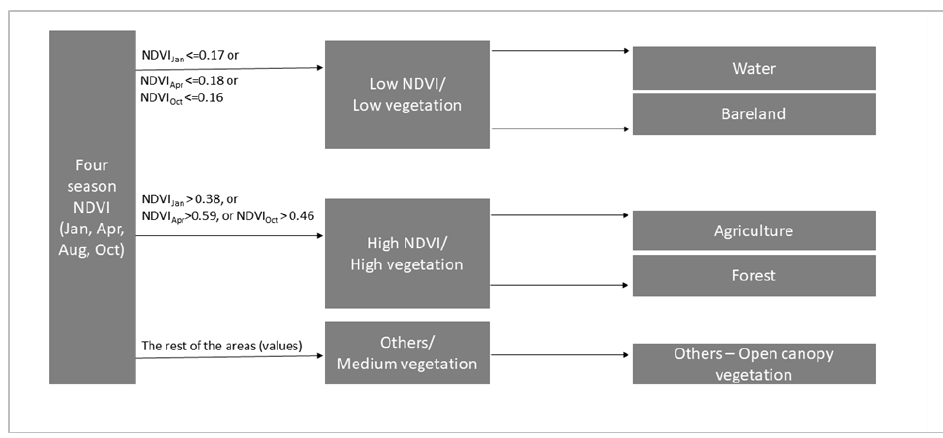
Figure 8. Rules-based decision tree to classify land-use and land cover in the High Atlas Mountains of Morocco. Table 6. Statistics of NDVI values for eight vegetation types (no vegetation, crop, crop and tree, grass/bushes, tree coarse, tree dense, tree very coarse, and tree very dense) in the High Atlas Moun- tains of Morocco. To separate means a pairwise multiple comparison procedure (Holm – Sidak Method) was used.